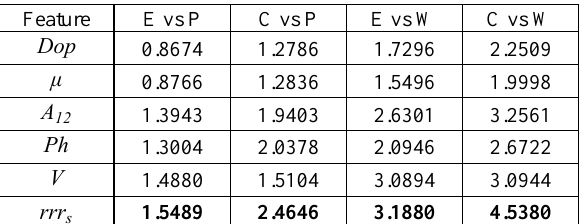
Table 4. The NDs between oil slicks and non-slicks of features in Radarsat-2 image. Where C, E, P, and W refer to crude oil, emulsion, plant oil, and water respectively.